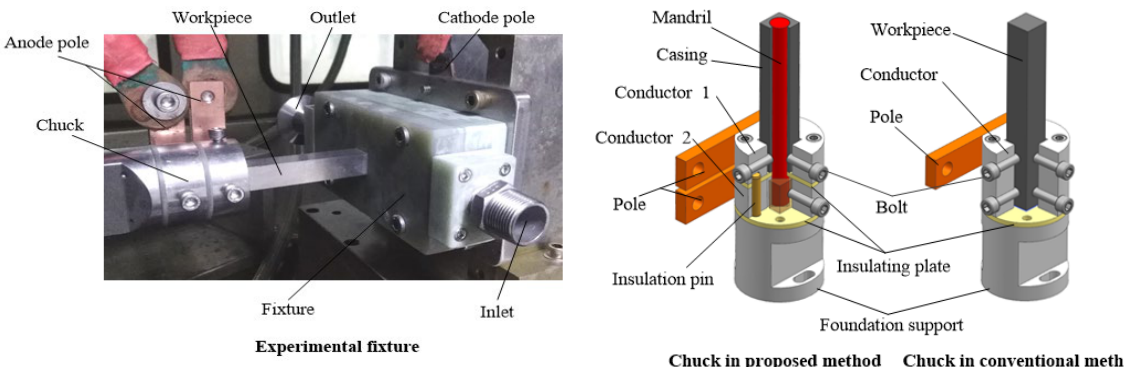
Figure 14. Experimental fixture and chucks. Table 3. Experimental conditions.